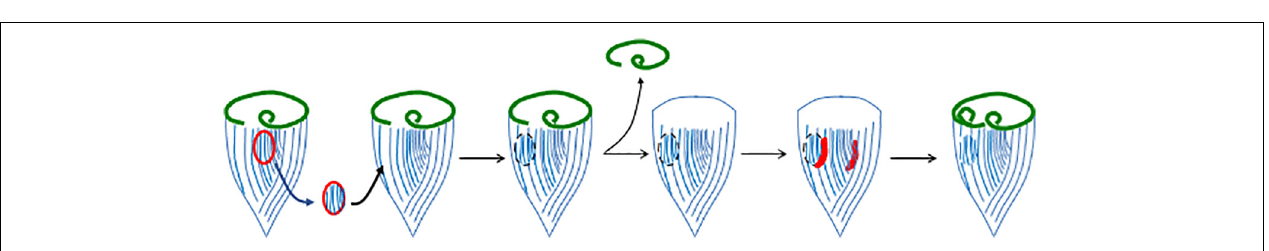
FIGURE 2 | Oral apparatus regeneration and reorganization in Stentor . When the original oral apparatus (green) is removed, an oral primordium (red) forms at the locus of stripe contrast. This primordium, consisting of thousands of basal bodies, organizes into a new oral apparatus as it migrates to the anterior end of the cell. The same process can also occur spontaneously, creating a reorganization in which the old oral apparatus is replaced by a new, usually larger one.